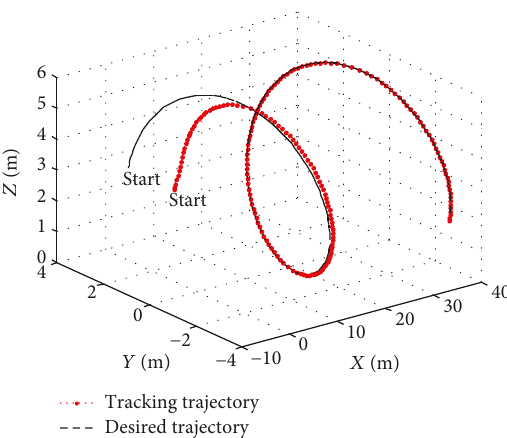
Figure 7: Simulation result using adaptive sigma-pi neural network control.